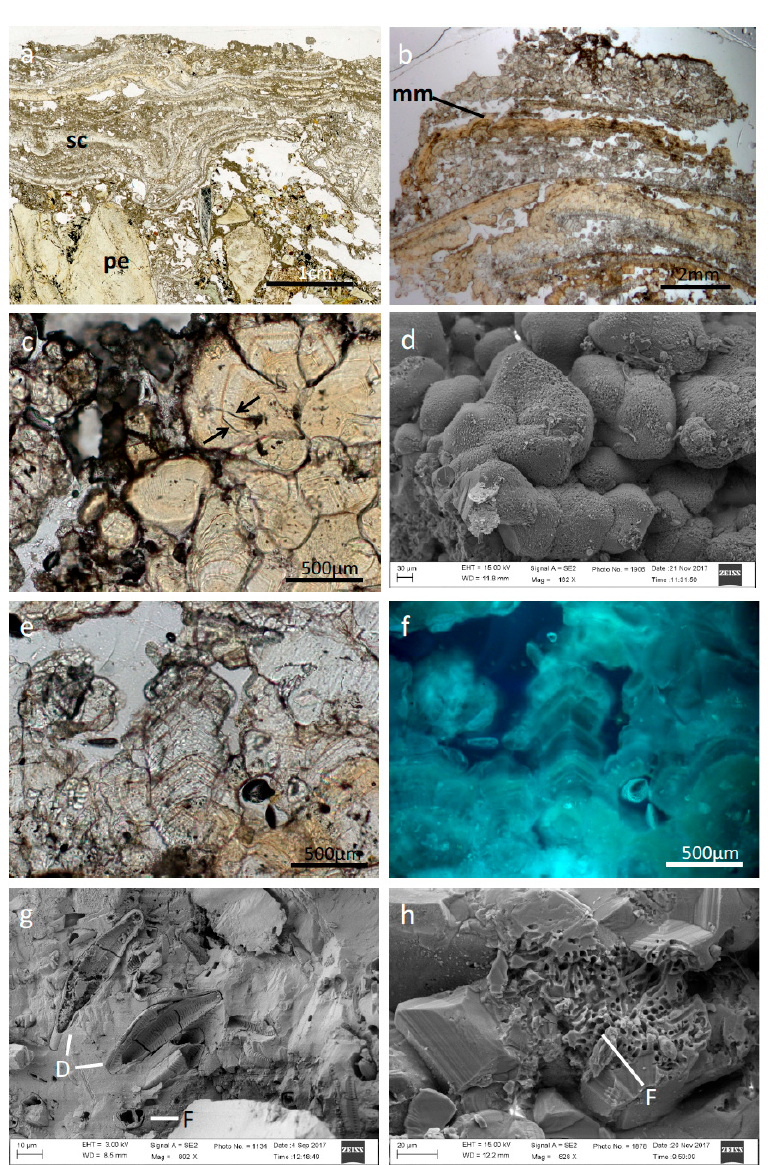
Figure 2. Microstructure of representative carbonate buildups from Torrente Lerone: ( a ) Travertine-like spring carbonate buildups: stromatolitic crusts (sc) overgrowing ultramafic rock pebbles (pe). ( b ) Detailed view of a stromatolitic crust exhibiting mineralized microbial mats (mm, light yellow crusts) alternating with grey calcites and micritic portions. ( c ) Magnified view of the light-yellow anhedral calcites showing entrapped microbial remains (arrows). ( d ) Field emission electron microscopic (FE-SEM) view of the light-yellow calcites. ( e ) Grey-white scalenohedral calcite with growth laminae. ( f ) Same specimen as ( e ) under UV-fluorescence excitation. Blue fluorescence is caused by intracrystalline organic matter. ( g ) FE-SEM view of the grey-white calcites. Frustules of pennate diatoms (D) and holes as remains of microbial filaments (cross sections; F) are visible. ( h ) FE-SEM view of the light-yellow calcites with remains of filamentous microbes